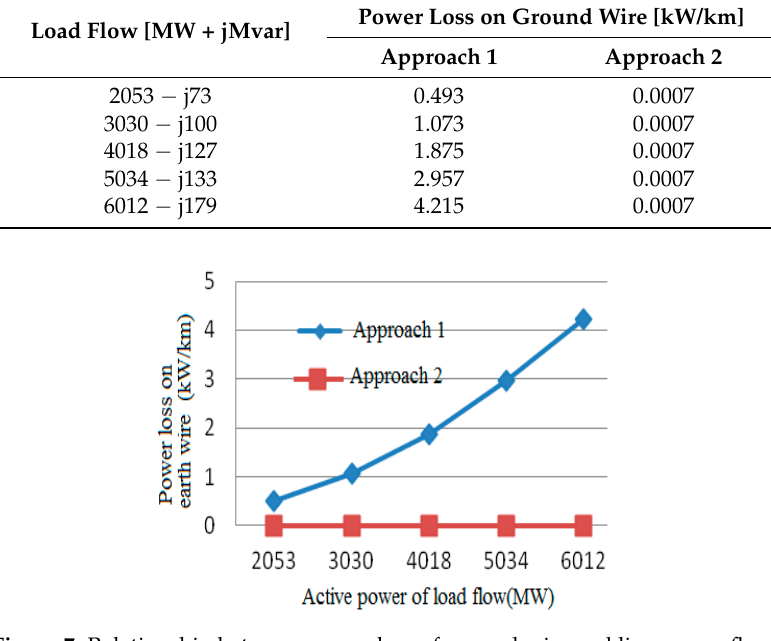
Figure 7. Relationship between power loss of ground wire and line power flow.